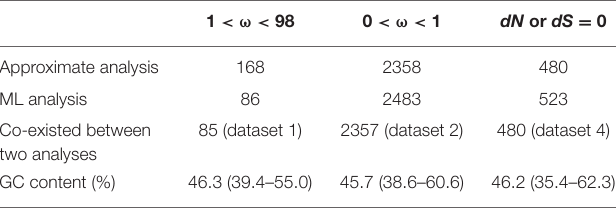
TABLE 1 | Summary of the selective pressure analyses.